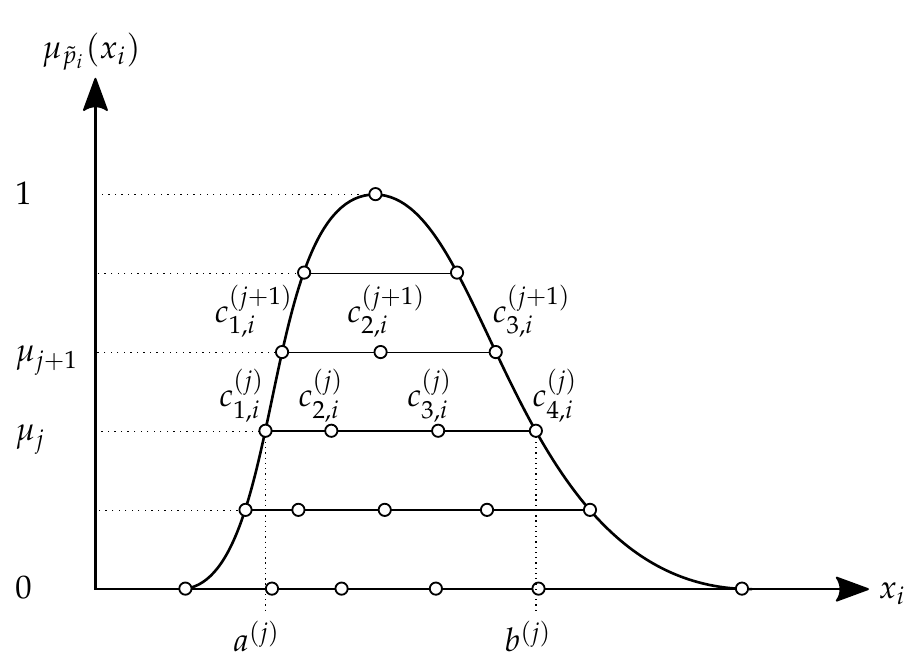
Figure 2. Decomposition pattern according to the General Transformation Method [11]